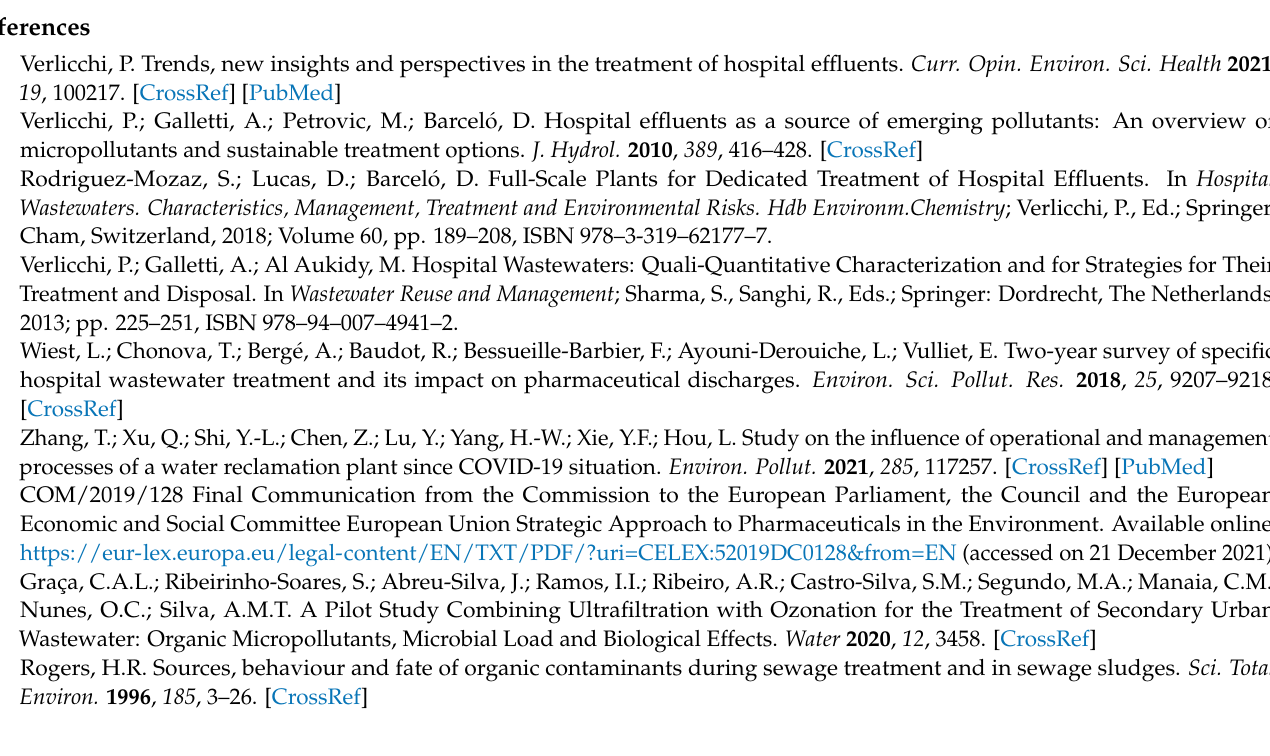
Table S5: Strengths, weaknesses, opportunities, threats for O 3 /UV